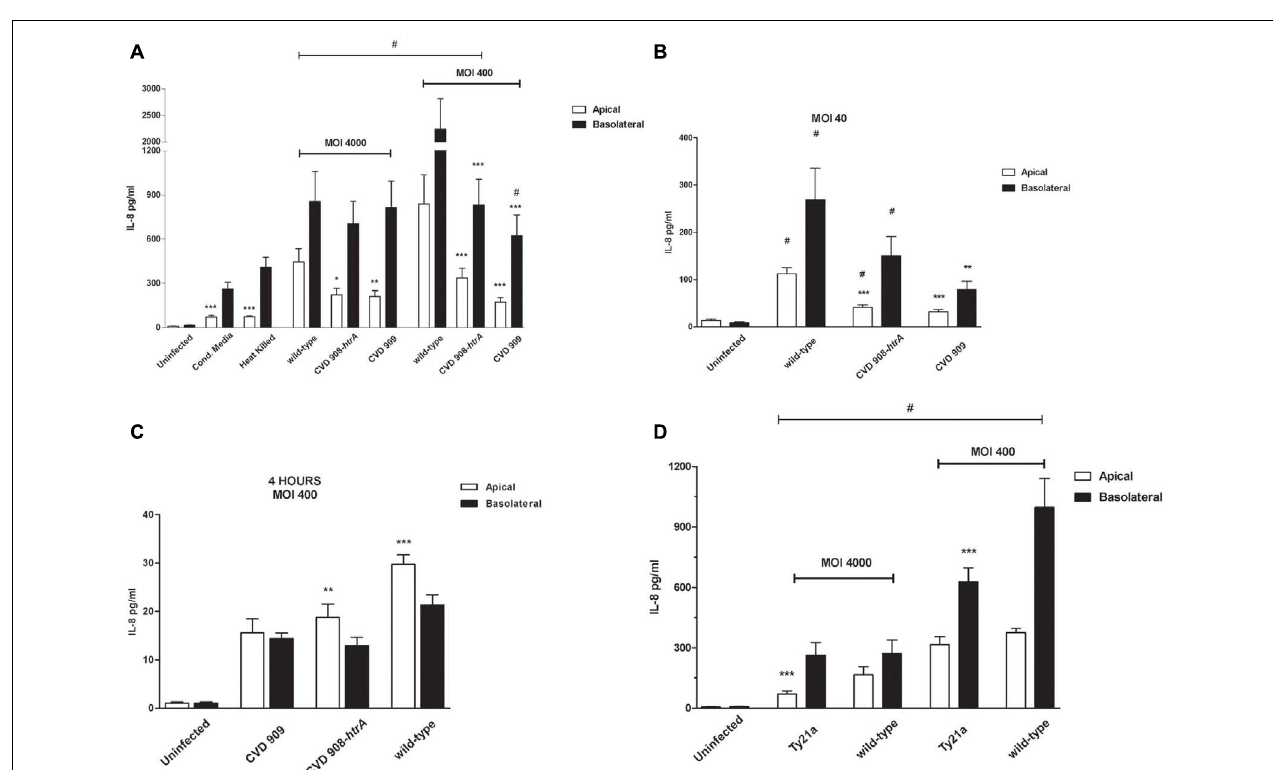
between the apical and basolateral compartments for the same strain); (D) IL-8 measured at 22h after infection with the vaccine strainTy21a applied at MOIs of 4000 and 400.Wild-type S .Typhi served as positive control.Values shown represent the mean ± SEM of three independent assays. # p < 0.05 over uninfected; *** p < 0.001, ** p < 0.01, * p < 0.05 for comparisons between wild-type S .Typhi and mutant strains applied at the same titer